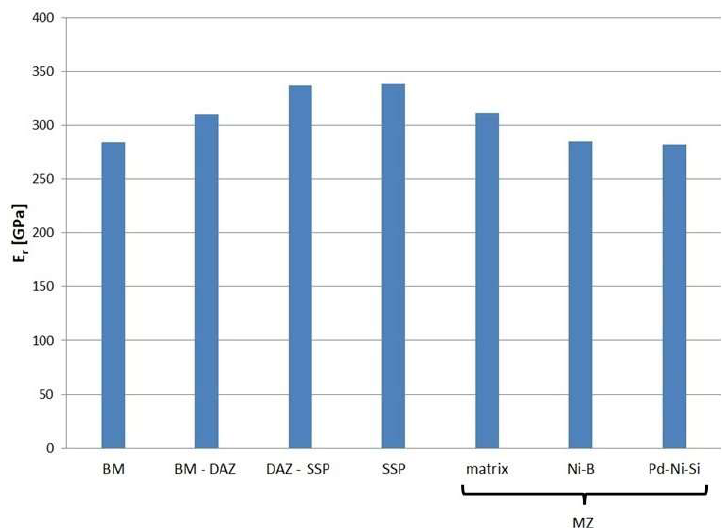
Figure 13. Reduced modulus of the indentation contact of structure elements in the joint.